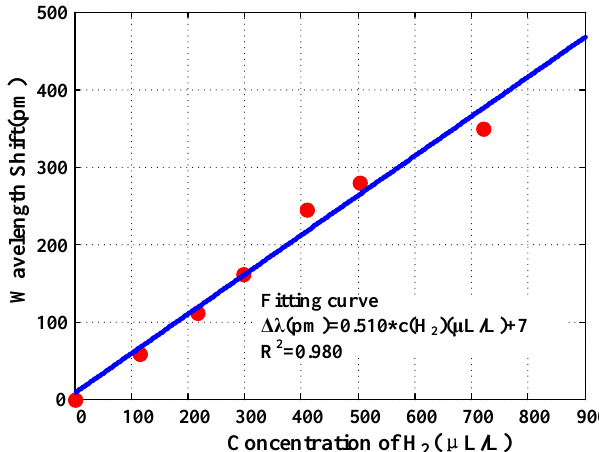
Figure 8 . Wavelength shifts at different hydrogen concentrations. Figure 8. Wavelength shifts at different hydrogen